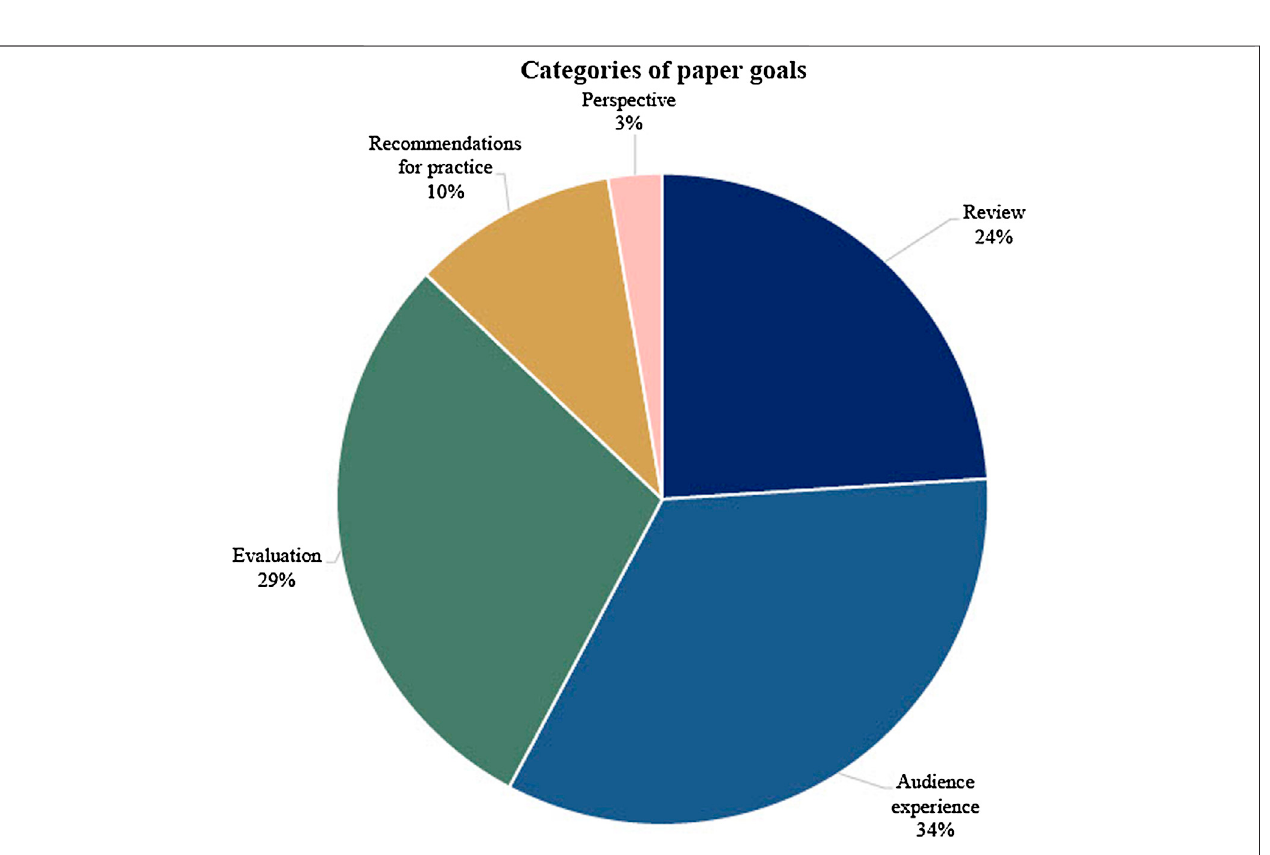
FIGURE 5 | Composition of paper goals within included articles. Eleven (11) articles had two or more identi fi ed goals, meaning the total count exceeds the sample size ( n (cid:1) 213).